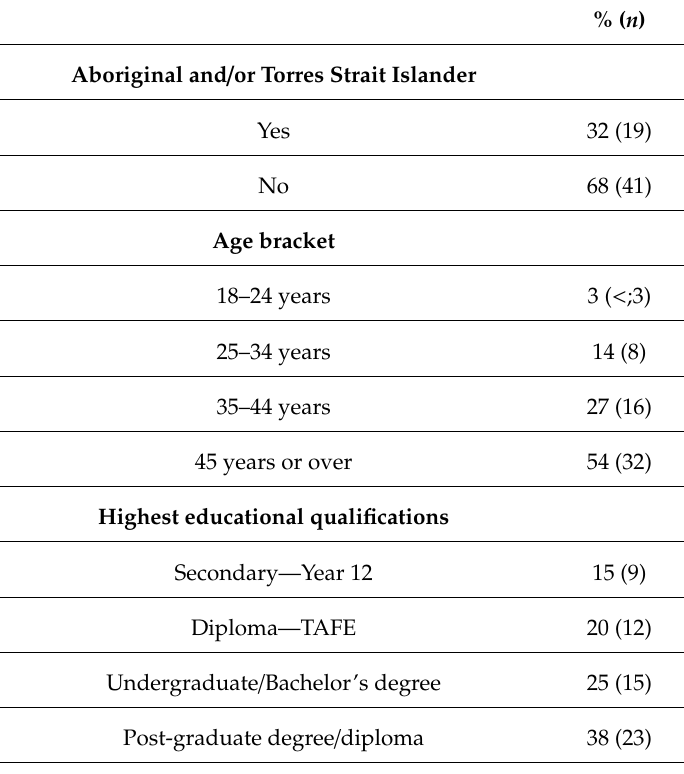
Table 2. Characteristics of survey respondents ( N =